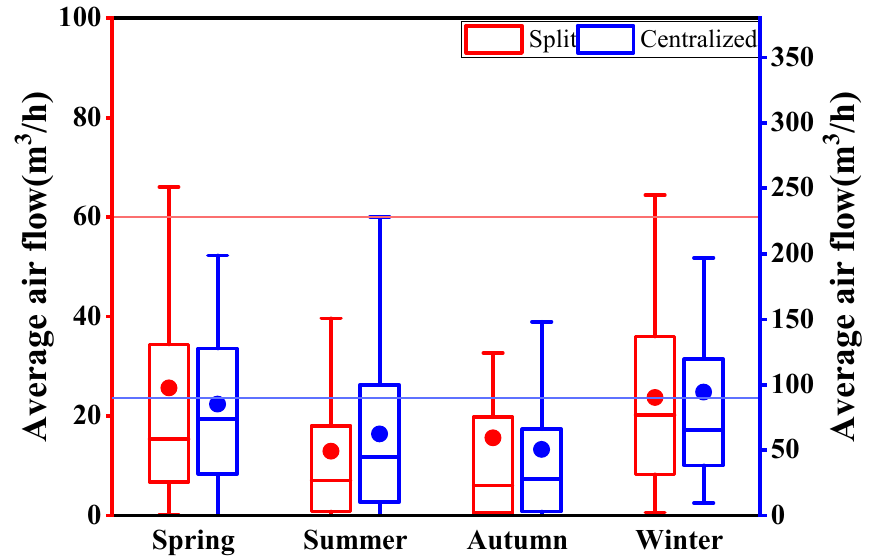
Figure 7. Boxplots of the average ventilation volumes of the two type systems in different seasons: the split system and the centralized system.